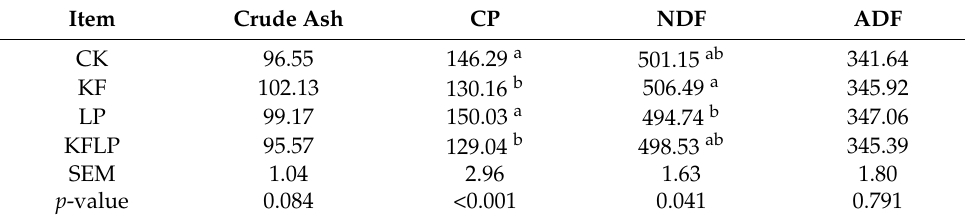
Table 2. The chemical composition of forage rape silages fermented with KF and LP for 60 days (g/kg